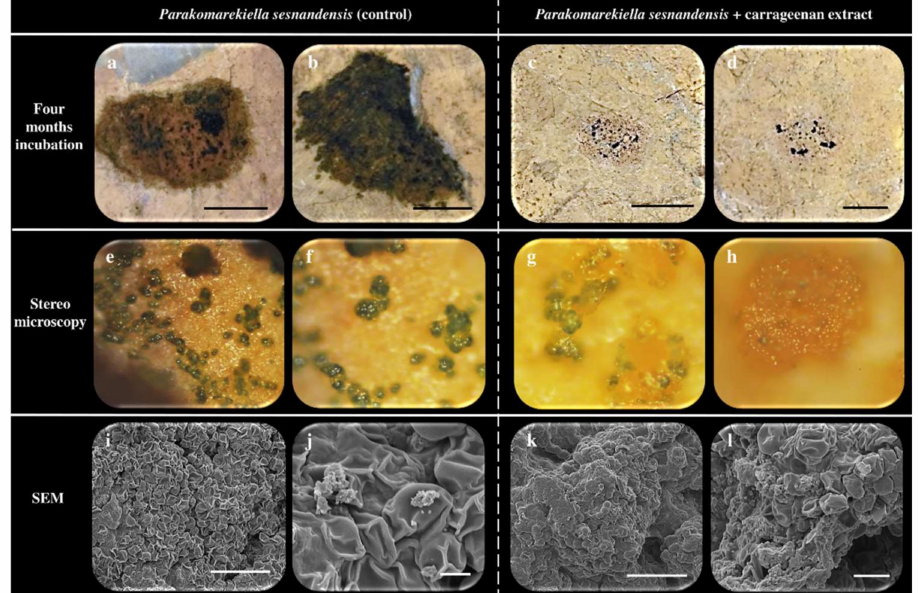
Figure 1. Results regarding visual examination (stereomicroscopy and SEM) of the stone probes inoculated with Parakomarekiella sesnandensis in the absence ( a , b , e , f , i , j ) and in the presence ( c , d , g , h , k , l ) of 200 µ L of kappa/iota hybrid carrageenans, after 4 months of incubaction. Scale bars: ( a – d ) = 1 cm;